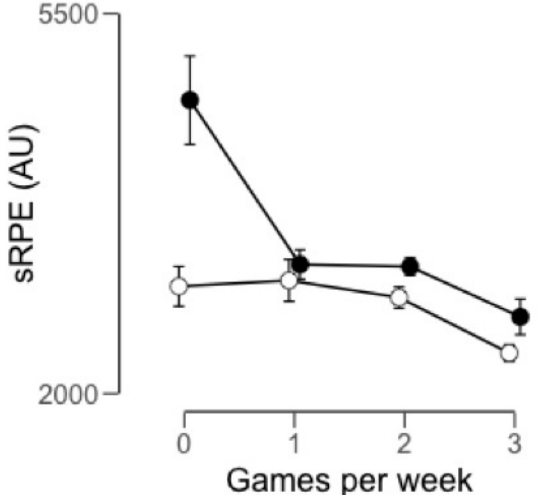
Figure 4. Average session rating of perceived exertion (sRPE) in arbitrary units (AU) by the number of games played within a week and for the seasons 2017–2018 (o) and 2018–2019 ( ● ).